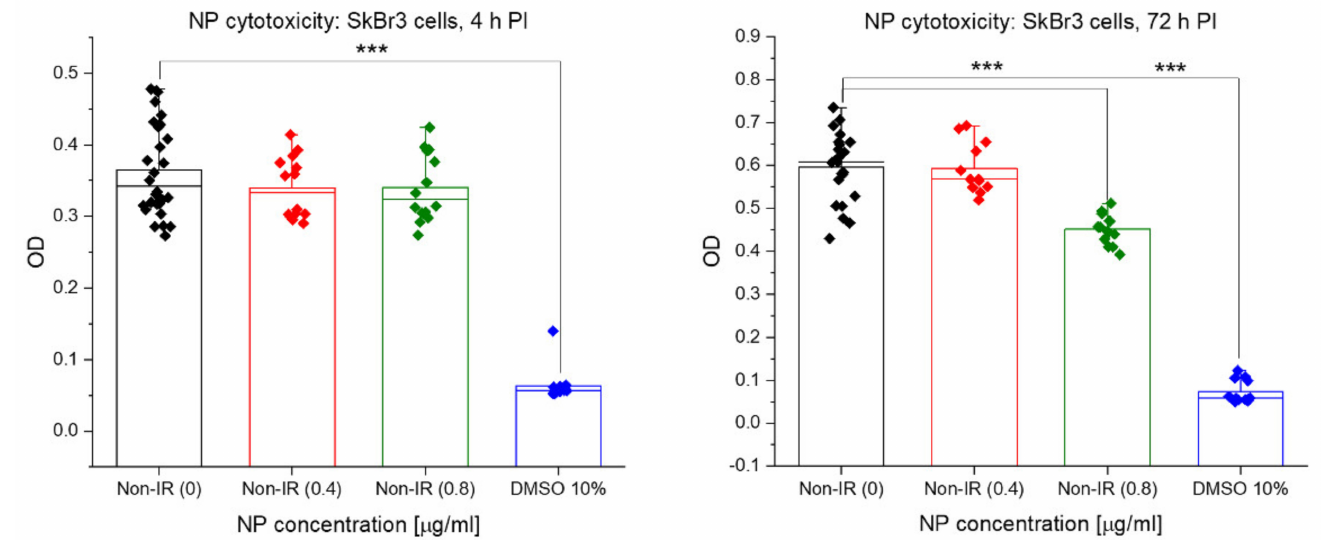
Figure 14. Cytotoxicity of GNPs by MTT test. Cell viability is measured in dependence of GNP concentration (0, 0.4 or 0.8 µ g/mL) at 4 h ( left ) and 72 h PI ( right ), respectively. Post-irradiation times here, in non-irradiated samples, refer to the time points when the irradiated counterparts were evaluated. It means that the irradiated and non-irradiated samples were processed in the same way except of irradiation and analyzed in parallel. Four to six independent measurements for each irradiation dose are averaged and shown as the mean ± SD. Asterisks denote statistical significance of differences between indicated samples at p = 0.05 (*), p = 0.01 (**) or p = 0.001 (***). Two-tailed t -test, two-tailed t -test with Welsh correction or Mann–Whitney Rank Sum Test was used depending on the distribution normality of the analyzed